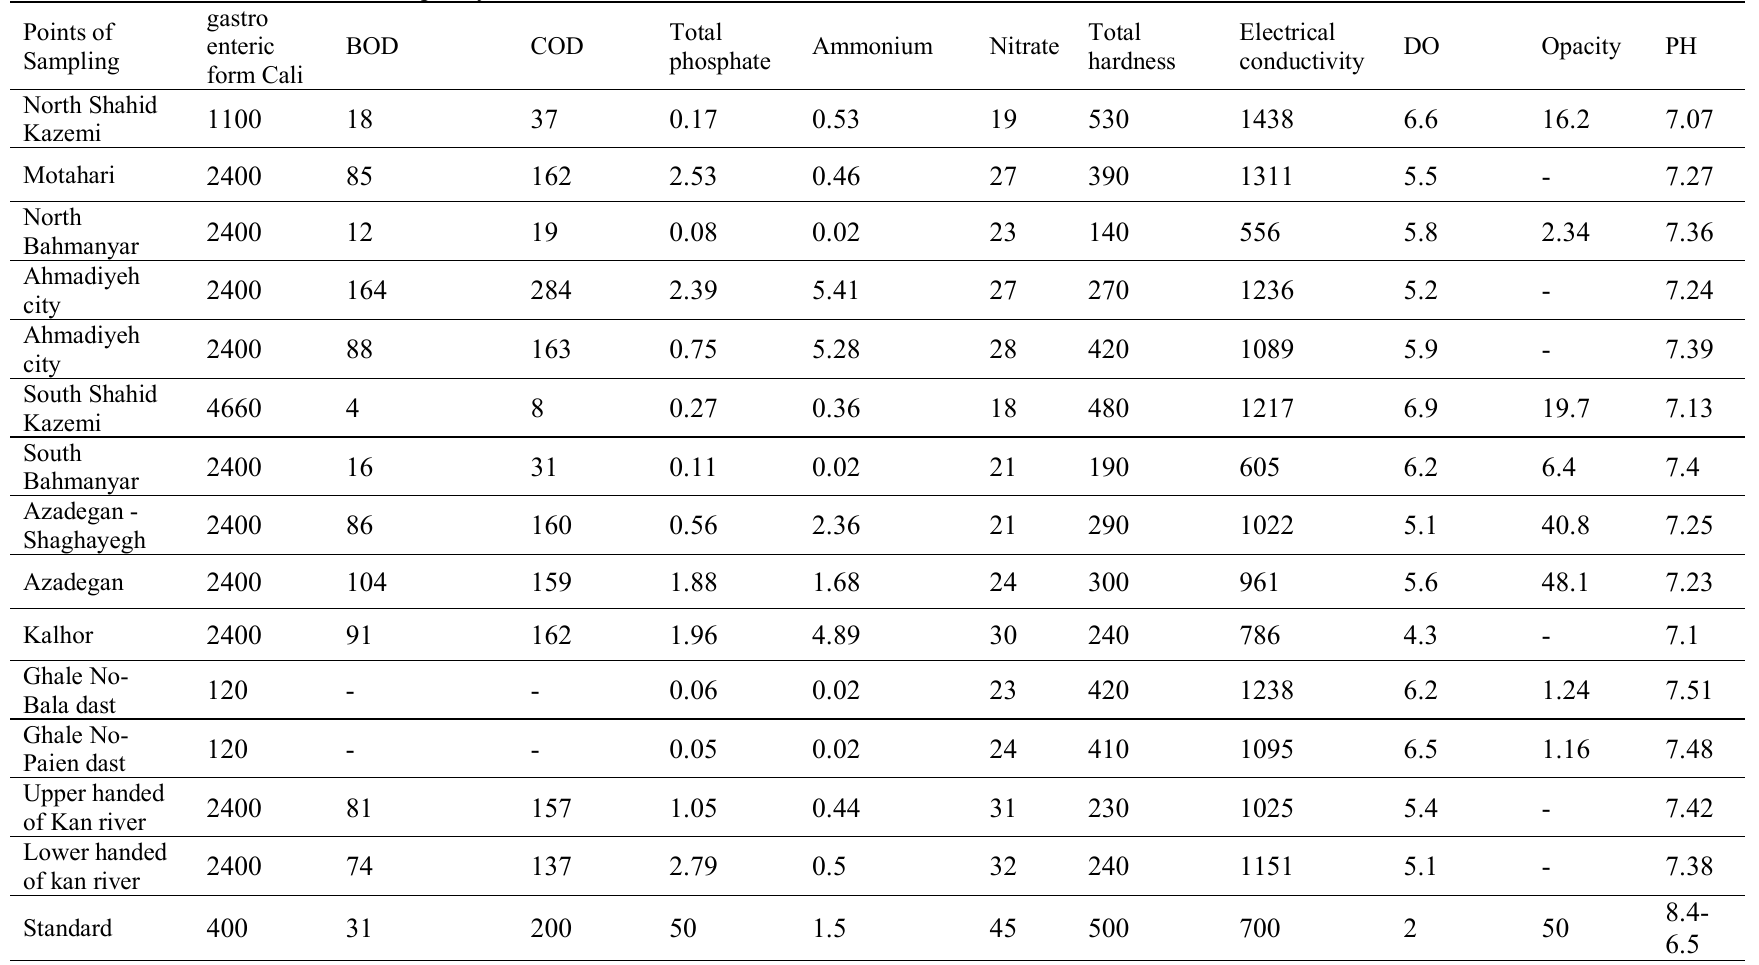
Table 5 . Results from surface water quality